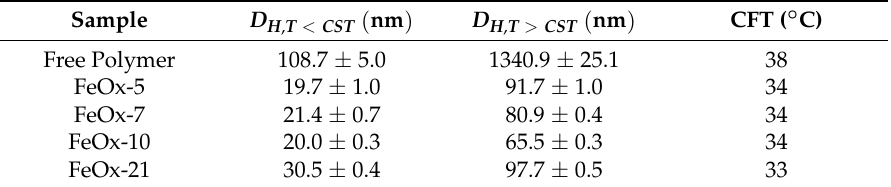
Figure 3. Dynamic light scattering (DLS) heating curves of 1 g L − 1 samples: black: free polymer, red: FeOx-5, green: FeOx-7, violet: FeOx-10 and blue: FeOx-21. The inset shows the same data exclusively for the nanoparticle dispersions. Table 3. Overview of D H of core-shell nanoparticles with a polymer concentration of 1 g L − 1 and their critical flocculation temperature (CFT) measured by DLS.